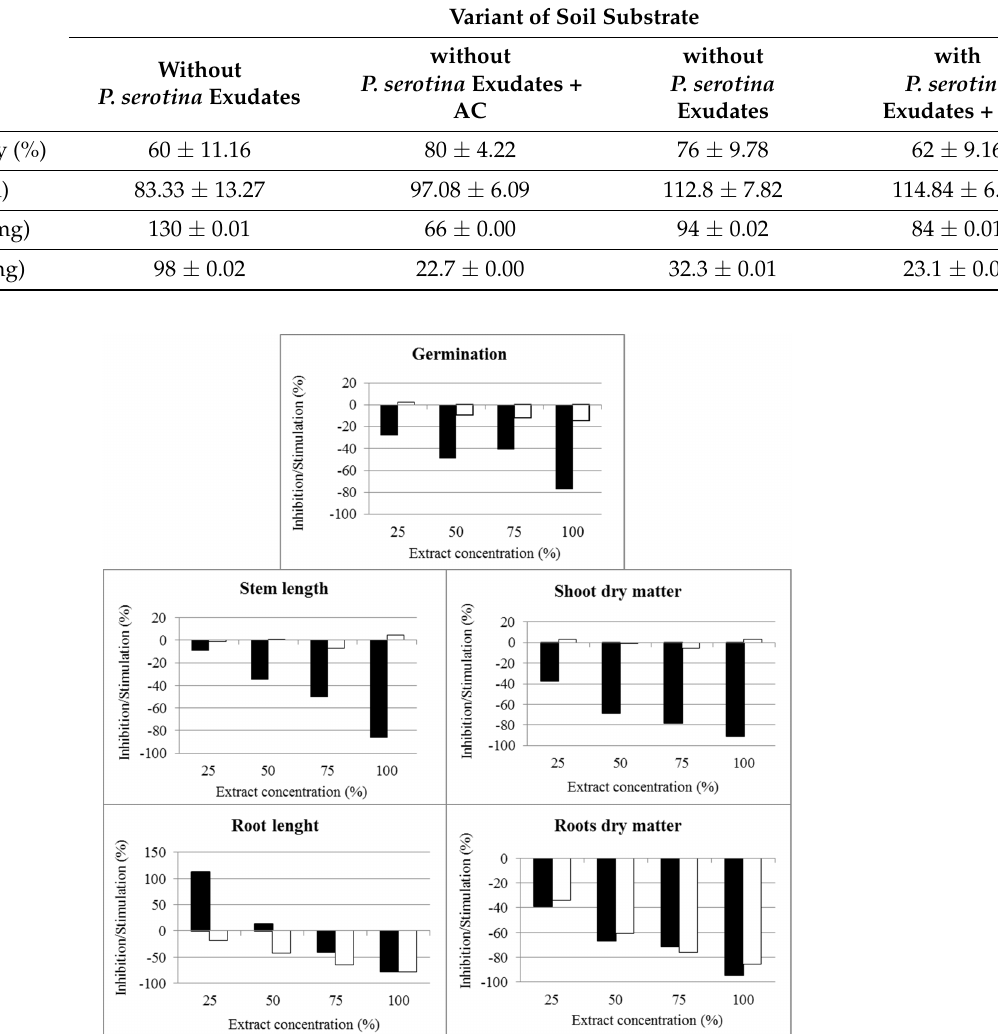
Figure 1. Inhibitory (-) or stimulatory (+) effects (over control) of leaf litter extracts of Prunus serotina on Sinapis alba (black bars) and Fagopyrum esculentum (white bars).